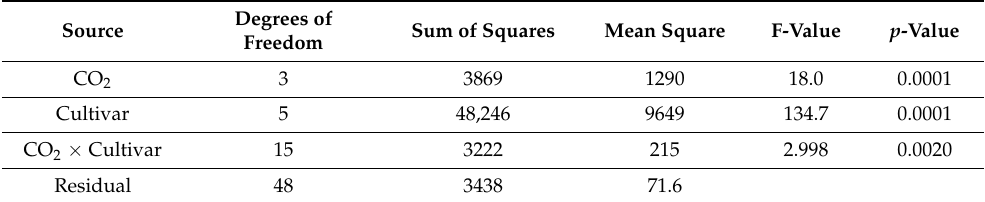
Table A2. Analysis of variance for area of third leaves of six bean cultivars grown at 26/20 ◦ C with four day/night CO 2 conditions.